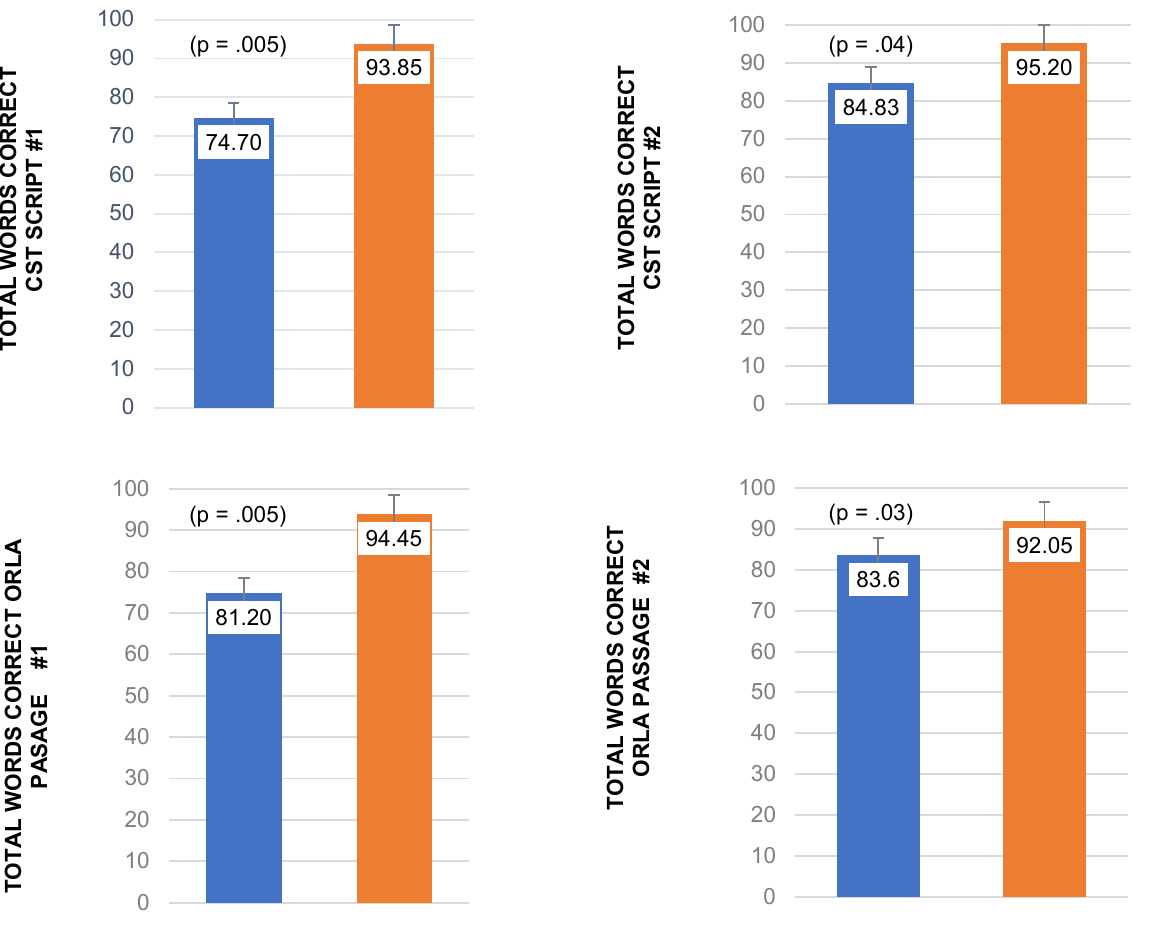
Group Means for Trained Communication Measures (CST and ORLA) Pre- and